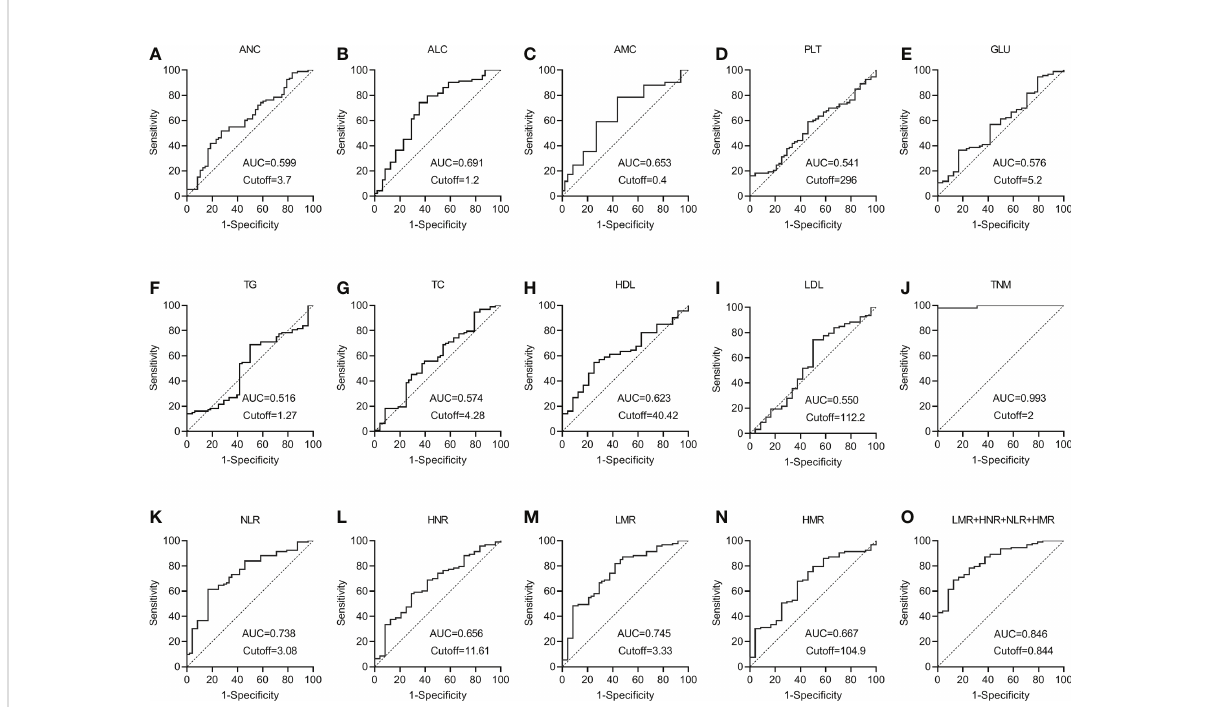
FIGURE 3 The diagnostic value of different blood markers in NSCLC metastasis (A) The diagnostic value of ANC in NSCLC metastasis. (B) The diagnostic value of ALC in NSCLC metastasis. (C) The diagnostic value of AMC in NSCLC metastasis. (D) The diagnostic value of PLT in NSCLC metastasis. (E) The diagnostic value of GLU in NSCLC metastasis. (F) The diagnostic value of TG in NSCLC metastasis diagnostic value in NSCLC metastasis. (G) The diagnostic value of TC in NSCLC metastasis. (H) The diagnostic value of HDL in NSCLC metastasis. (I) The diagnostic value of LDL in NSCLC metastasis. (J) The diagnostic value of TNM in NSCLC metastasis. (K) The diagnostic value of NLR in NSCLC metastasis. (L) The diagnostic value of HNR in NSCLC metastasis. (M) The diagnostic value of LMR in NSCLC metastasis. (N) The diagnostic value of HMR in